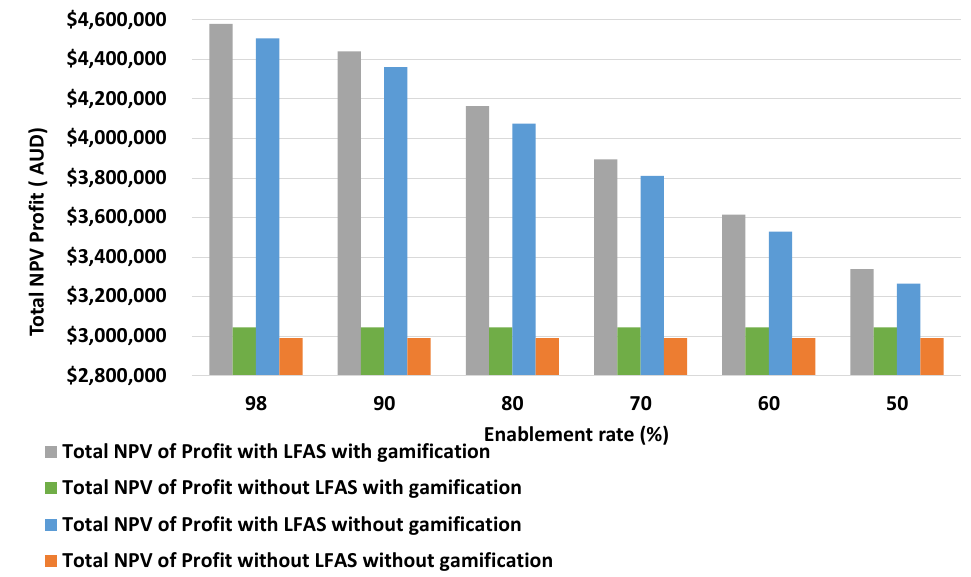
Figure 8. The total NPV of profit of the VPP project with and without gamification at different levels of enablement rate (%).